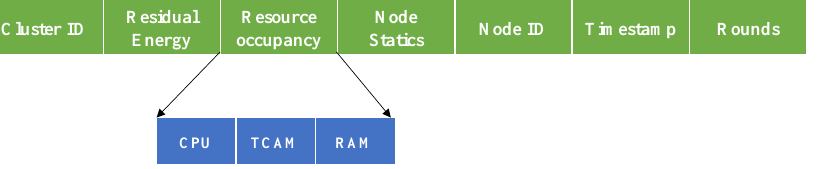
Figure 2. The format of a cluster-statistics message.